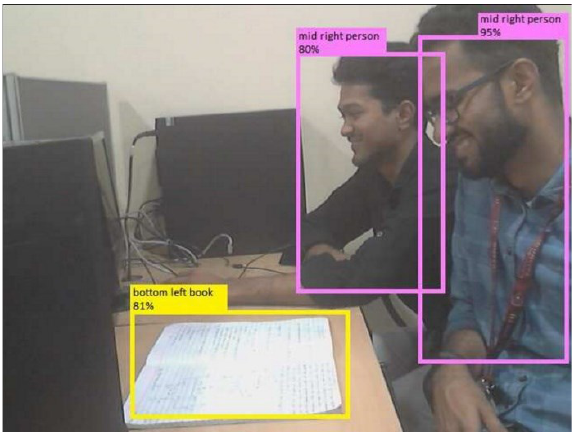
Figure 6. The output of YOLO algorithm for Frame-2.